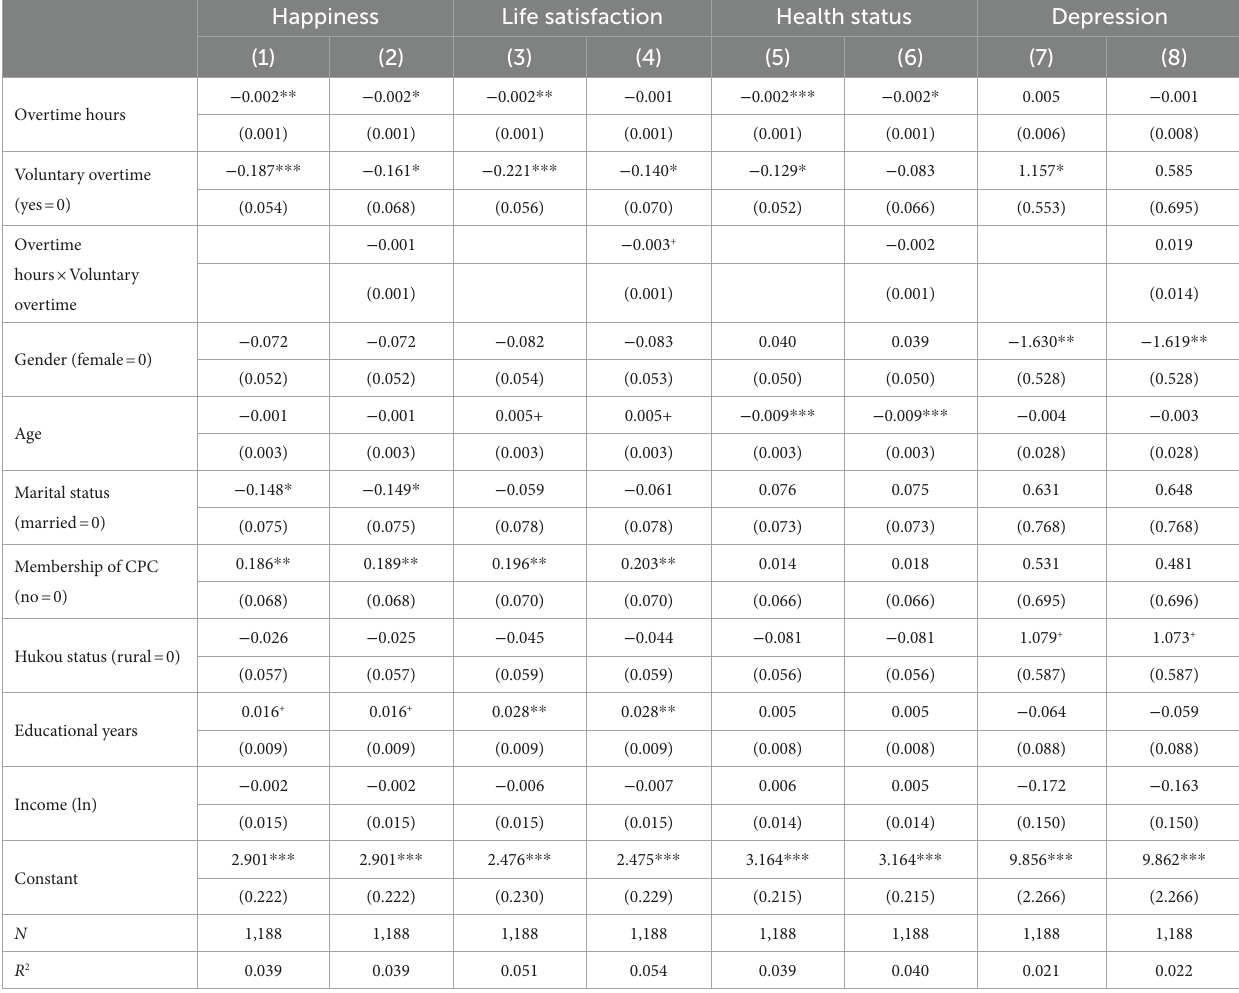
TABLE 4 Multiple linear regression of overtime hours and voluntary